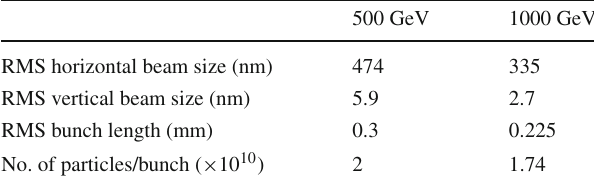
Table 5 Beam parameters corresponding to the center-of-mass ener- gies of 500 and 1000 GeV taken from Tab. 8.2 of ILC technical